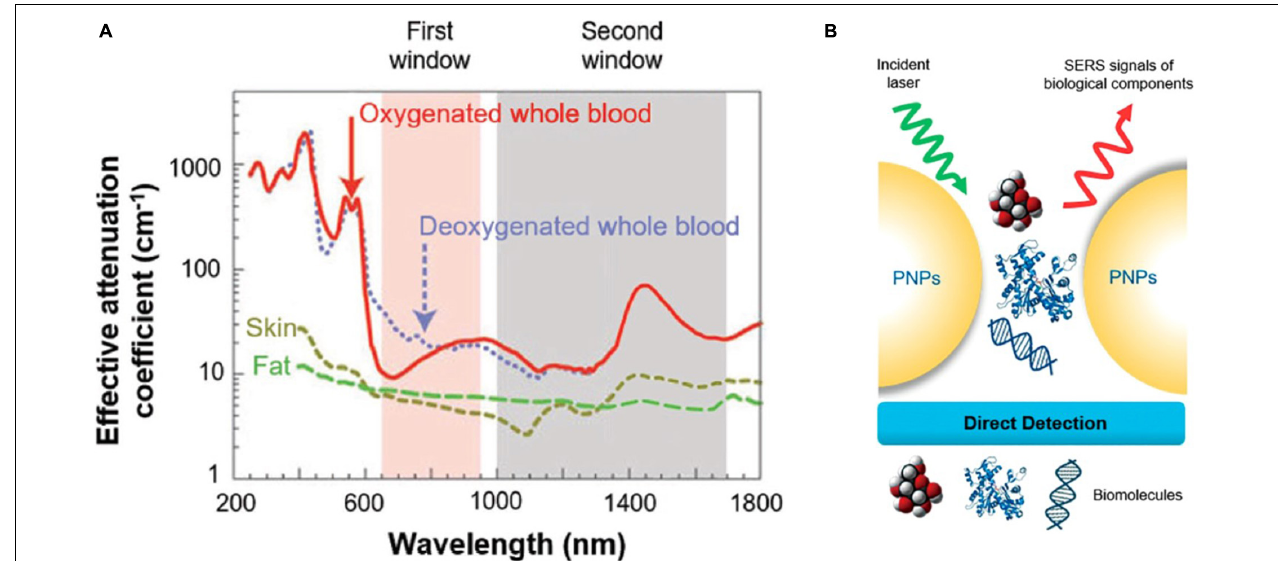
FIGURE 3 | Schematics of (A) near-infrared region, (B) surface-enhanced Raman spectroscopy. (A) The absorption spectrum of biological tissues spanning from 200 to 1,800 nm. The absorption and scattering of whole blood, skin, and fat are significantly reduced in either NIR-I (700–900 nm, shaded in pink) or NIR-II (1,000–1,700 nm, shaded in gray) window. Reprinted with permission from Kenry et al. (2018), Copyright (2018) John Wiley and Sons. (B) The direct SERS detection. Reprinted (adapted) with permission from Zong et al. (2018), Copyright (2018) American Chemical